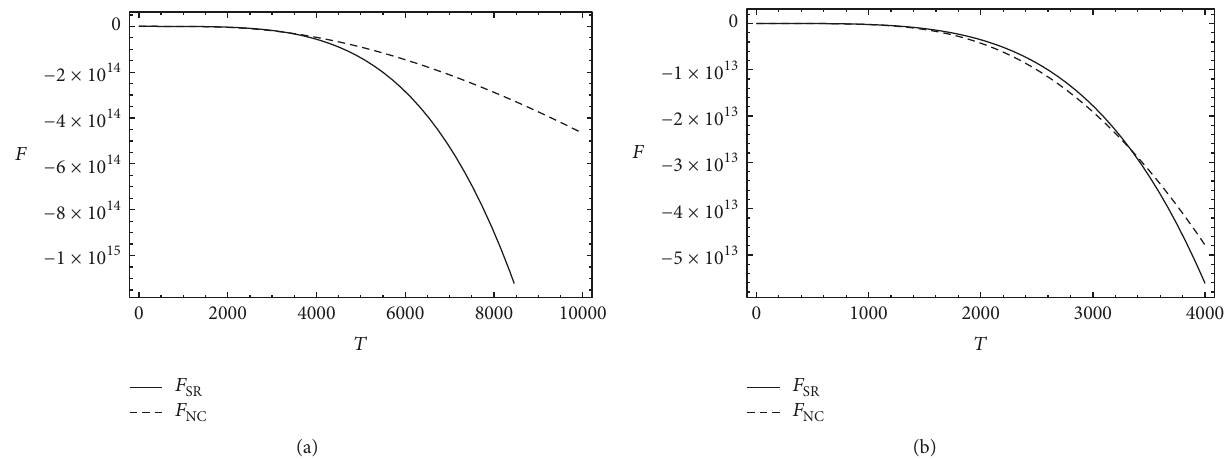
Figure 2: Free energy in SR and NC model. The units and the parameters are the same as in Figure 1. The NC model results have been obtained numerically using Mathematica